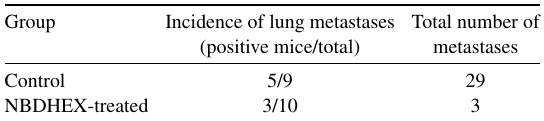
Metastatic ability in nude female mice intraveneously (i.v.) pre- treated with anti asialo GM1 antiserum 24 hours prior to the